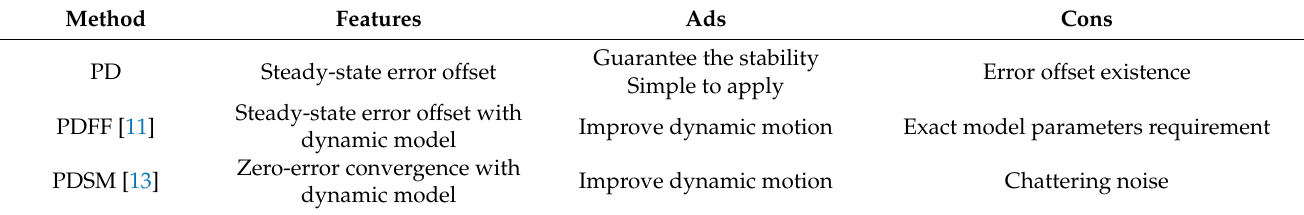
Table 12. The property comparison among the controllers and PDAFS.